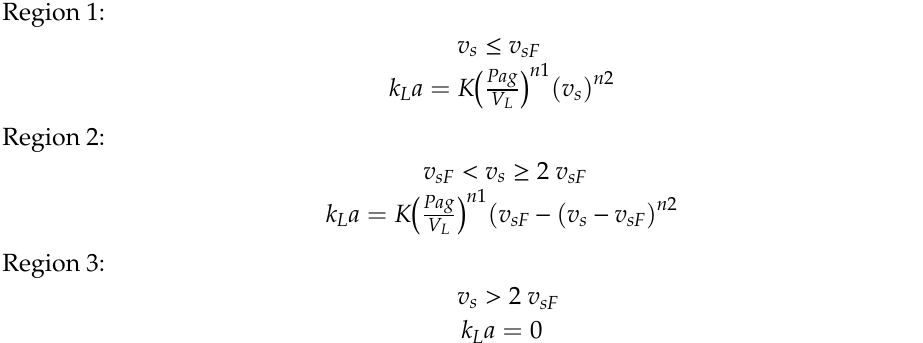
Figure 4. E ff ect of vvm and Pag on k L a in the non-flooded and flooded regions using a symmetrical Figure 4. Effect of vvm and Pag on k L a in the non ‐ flooded and flooded regions using a symmetrical k L a k L a model.